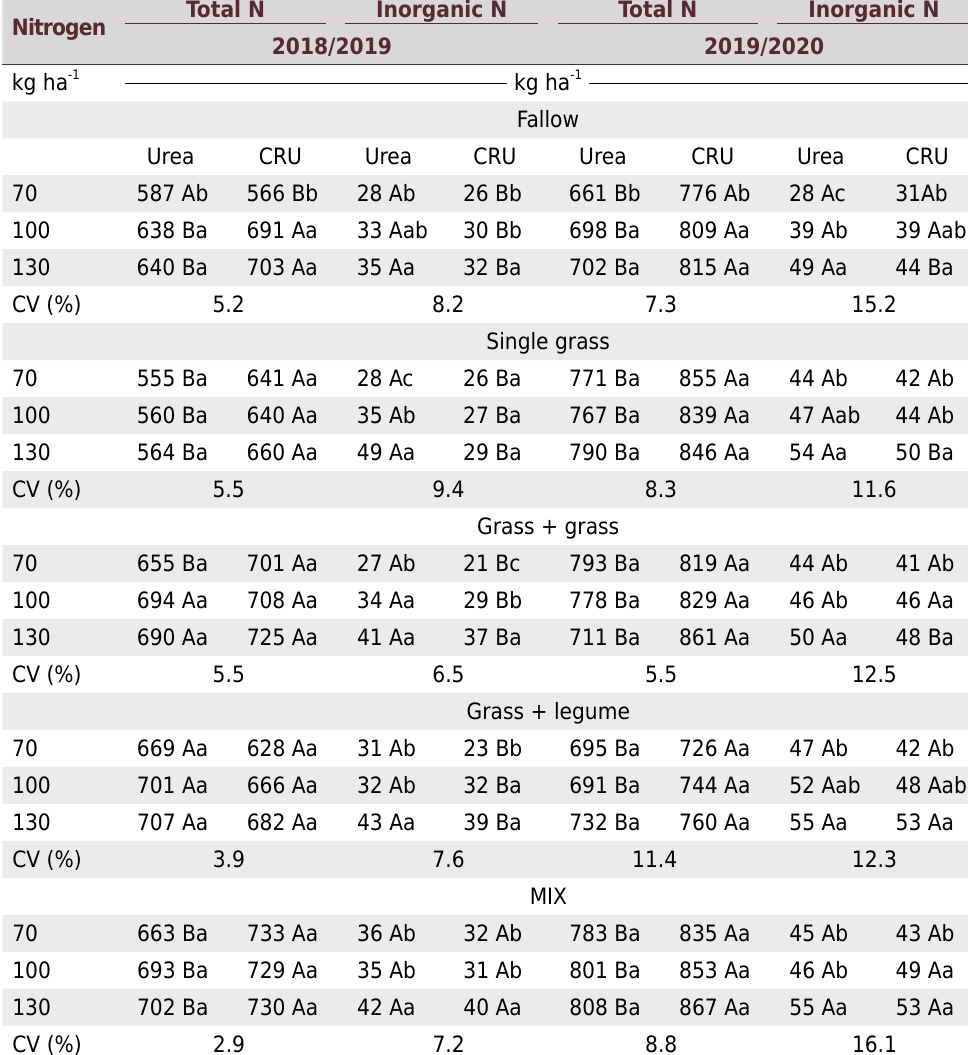
Table 1. Stock of total nitrogen and inorganic nitrogen in the soil (0.00-0.20 m) during the cotton flowering period